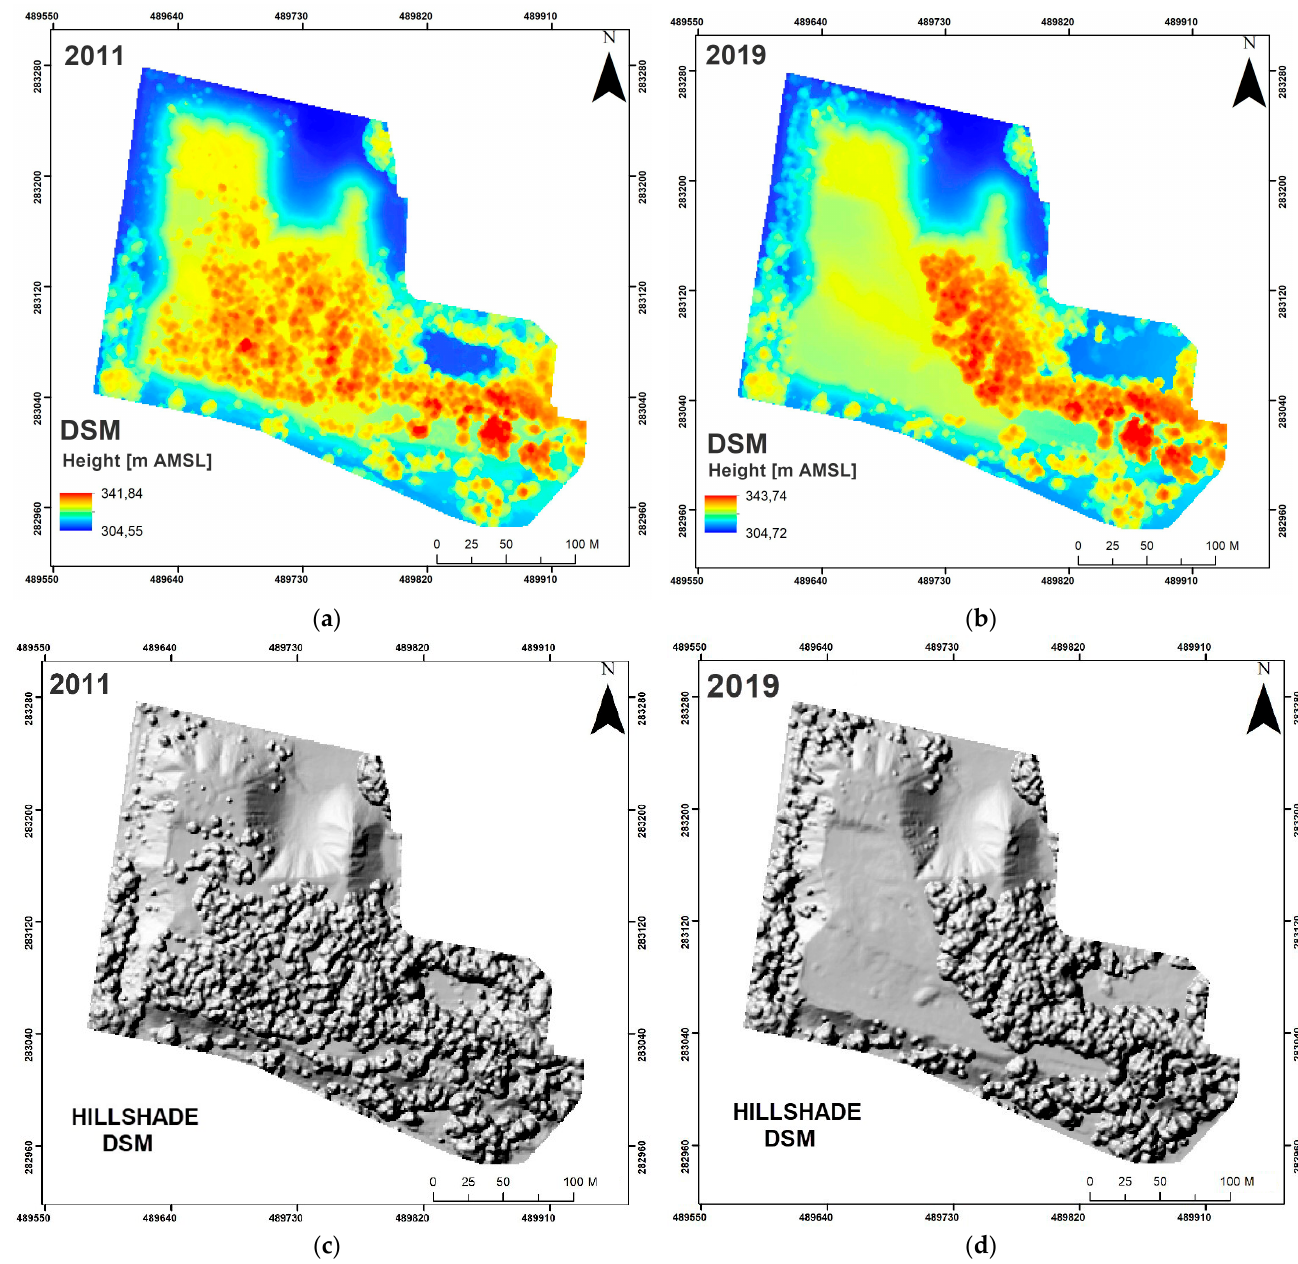
Figure 5. Digital surface model and hillshades: ( a , c ) 2011; ( b , d ) 2019.